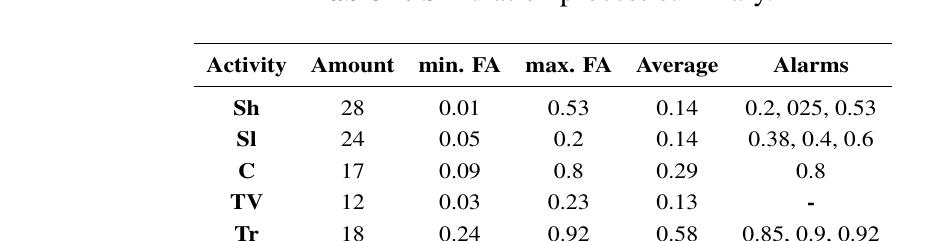
Table 4. Simulation process summary.